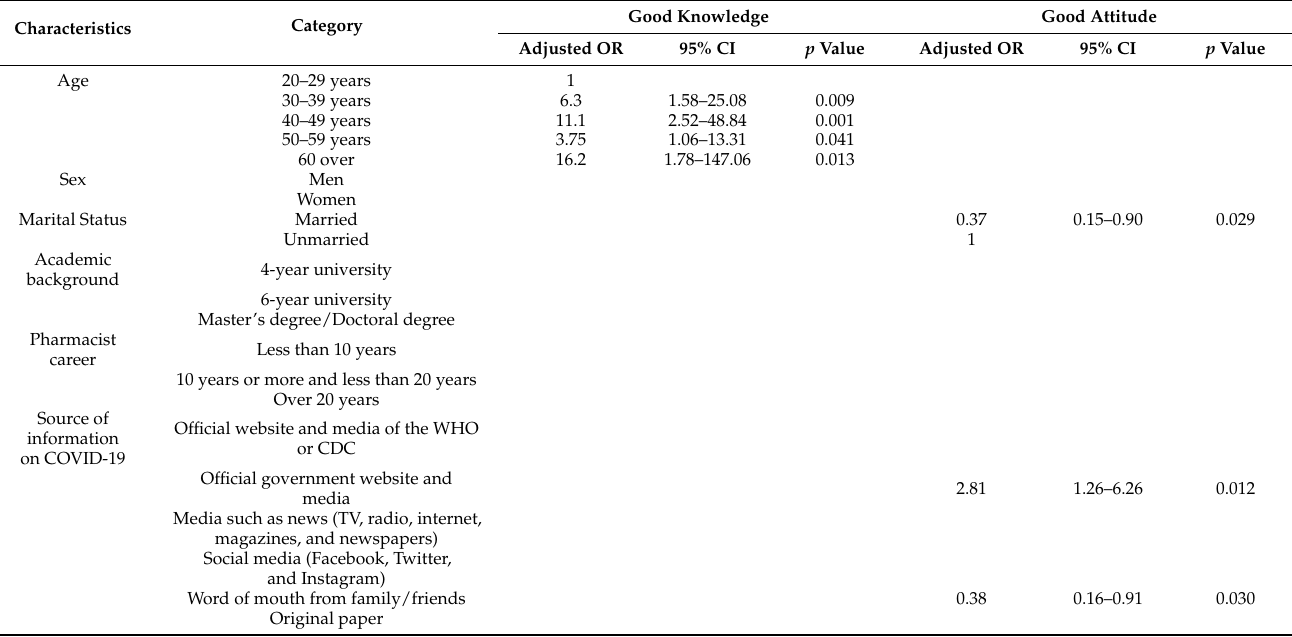
Table 7. Extraction of attribute factors related to knowledge, attitudes, and practices by stepwise logistic regression